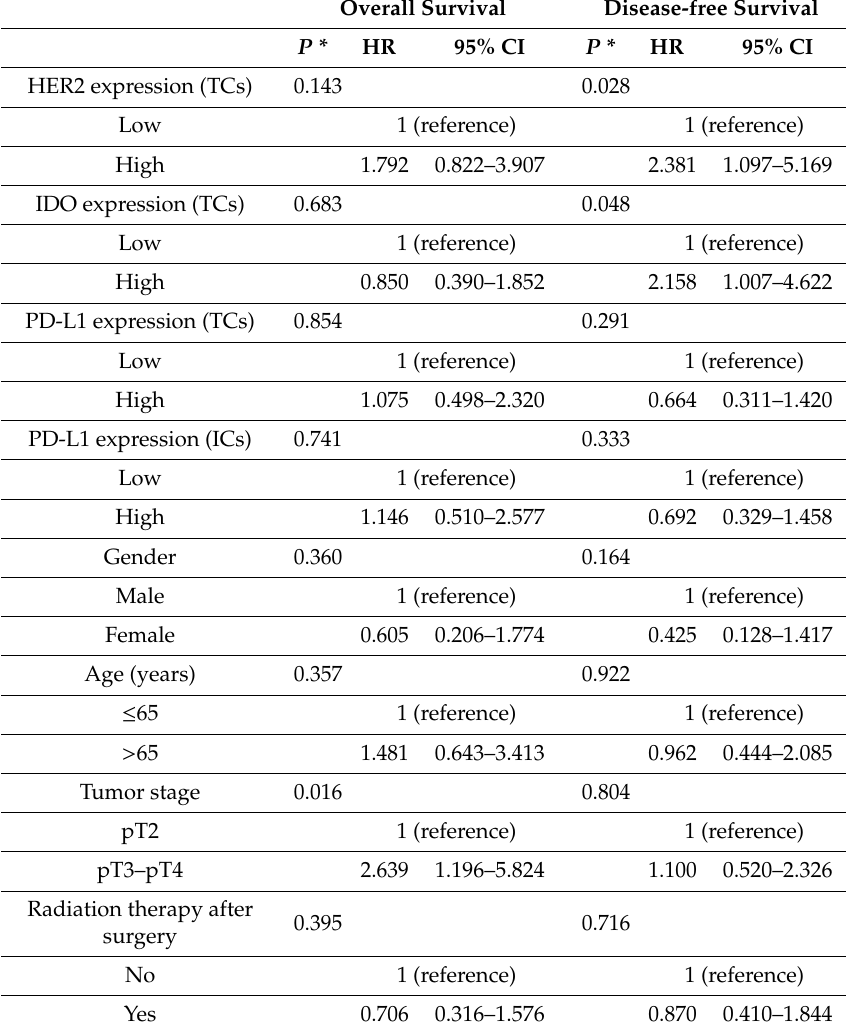
Table 3. Univariate analysis of overall survival and disease-free survival in 69 patients with pathologic tumor stage pT2–pT4 urothelial carcinoma of the bladder.